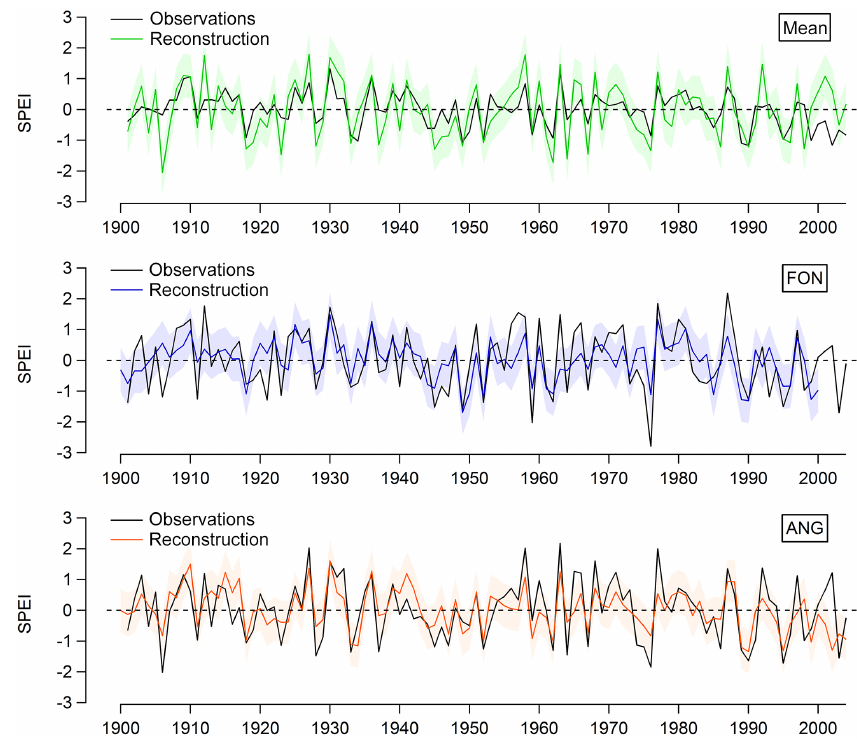
Figure 9. Observed and reconstructed drought indices SPEI (June–August). The shaded areas mark the confidence intervals of the recon-